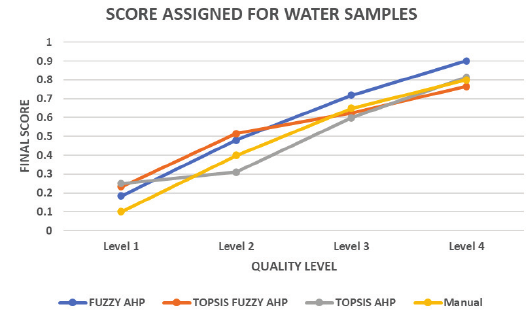
Fig. 5. Comparison of final score assigned for different water samples belonging to various quality